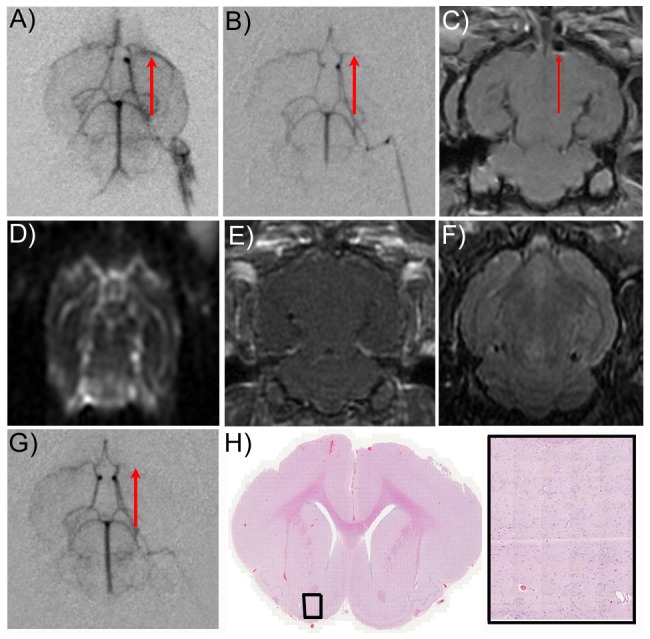
Emboli lodge in the middle cerebral artery.A) Omnipaque contrast agent was administered through the carotid artery while capturing a series of fluoroscopy images resulting in a baseline angiogram of the rabbit brain vasculature. B) Preformed arterial blood clots containing iron nanoparticles and measuring 2 mm3 in size were injected through a catheter inserted in the internal carotid artery. Post-stroke angiograms reproducibly located the blockage in the proximal MCA. C) TOF-MR images are used to confirm the location of the clot (red arrow) in the MCA by detection of the iron. X, Y, and Z coordinates were used to align the focal spot of the transducer with the superior distal portion of the clot for sonication. Diffusion weighted imaging (D), contrast enhanced T1 weighted imaging (E) and T2 weighted imaging (F) did not provide significant information and therefore were not used to evaluate the treatment. G) Control animals (no sonication) showed no evidence of reperfusion 1 hr later. H&E analysis of control animals at low (H) and high magnification (I) showed no evidence of tissue damage 1 hr post stroke induction.